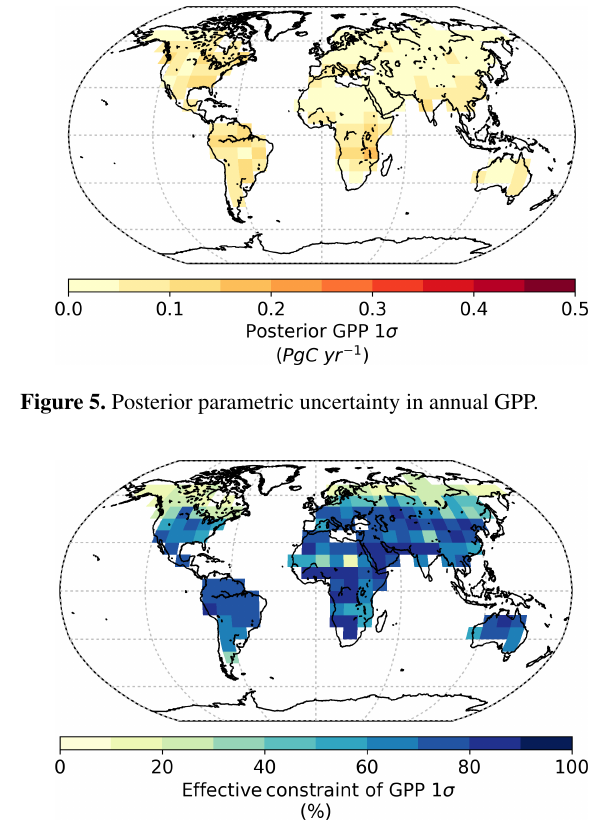
Figure 6. Relative uncertainty reduction (i.e. effective constraint) of parametric uncertainty in annual GPP from prior to